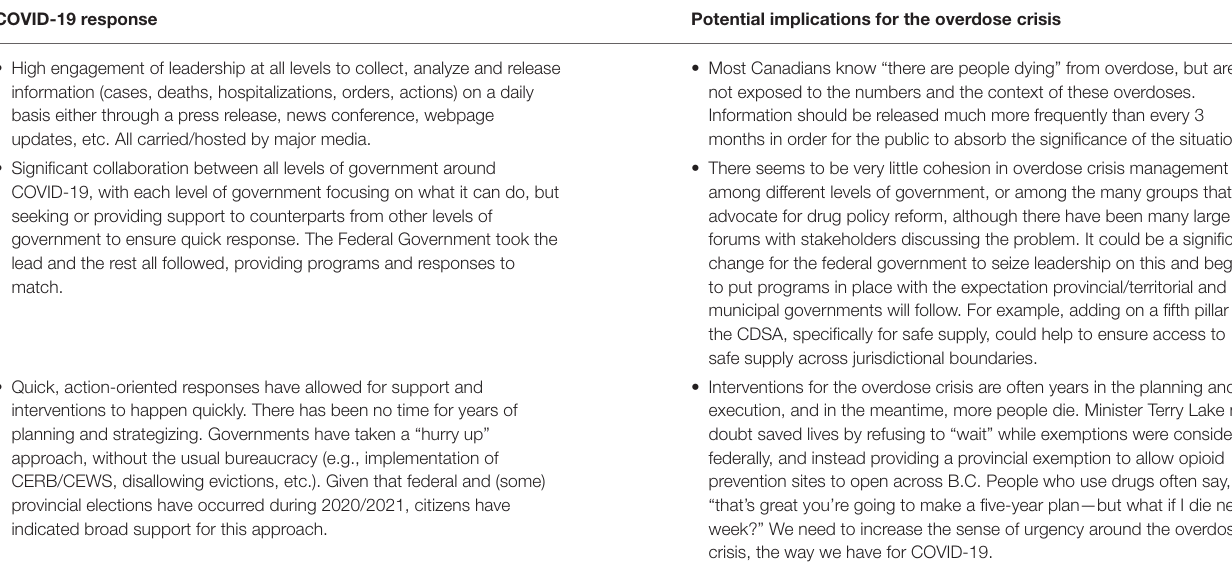
TABLE 5 | Lessons learned from the COVID-19 pandemic and potential implications for the overdose crisis. COVID-19